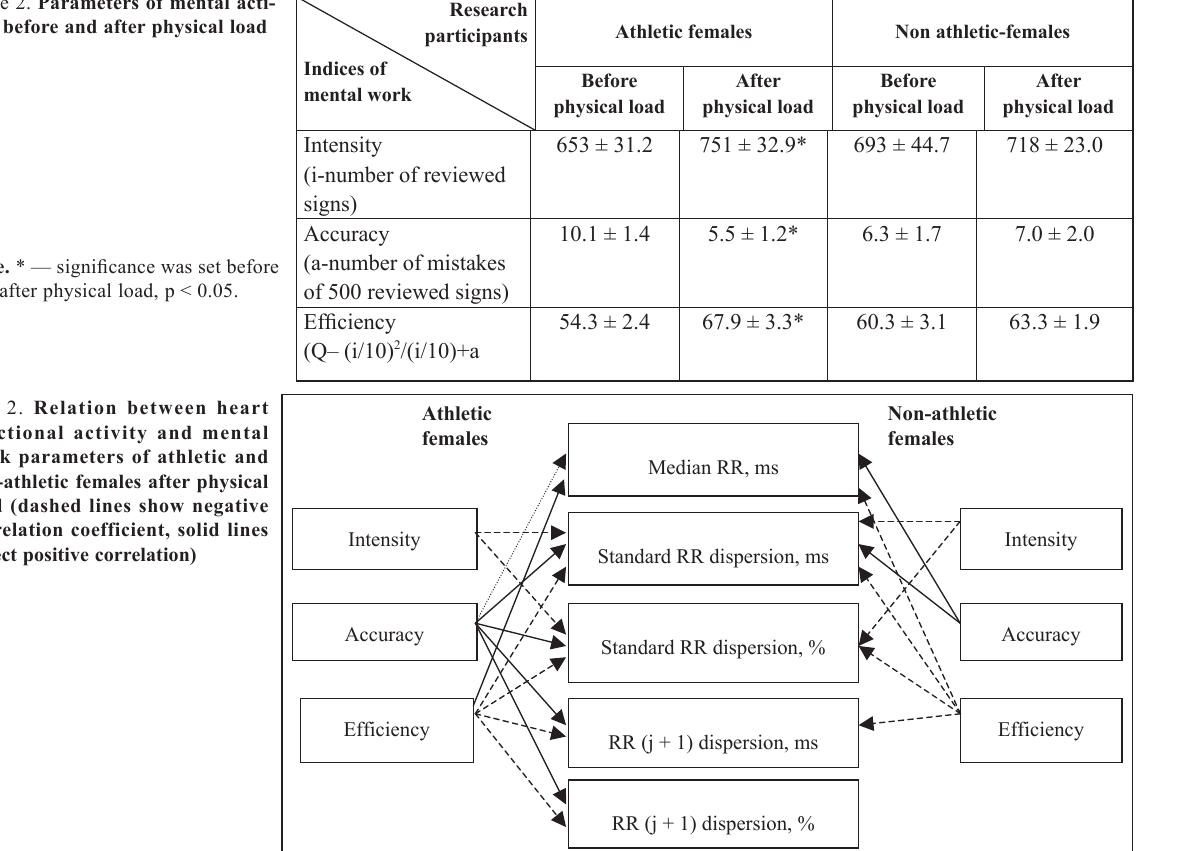
Note. * — signi fi cance was set before and after physical load, p < 0.05.